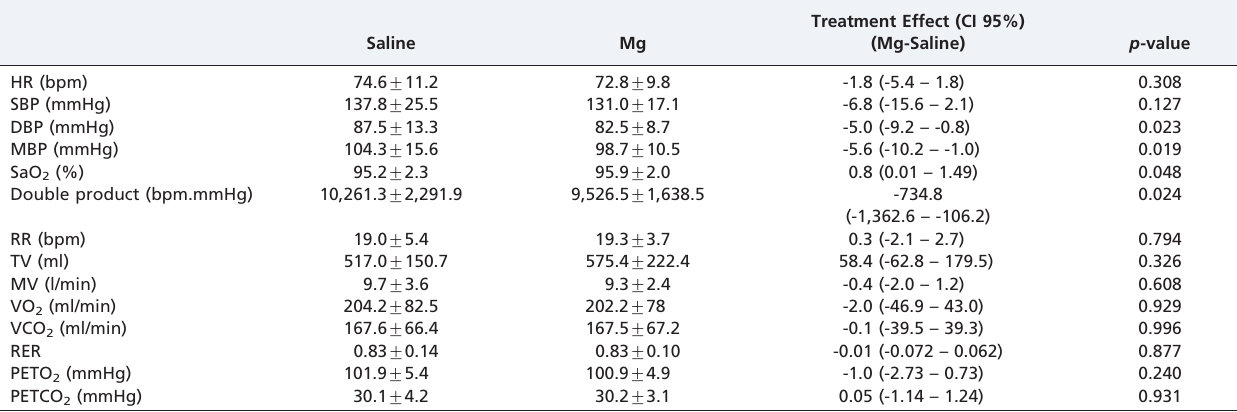
Treatment Effect (CI 95%) (Mg-Saline) p -value